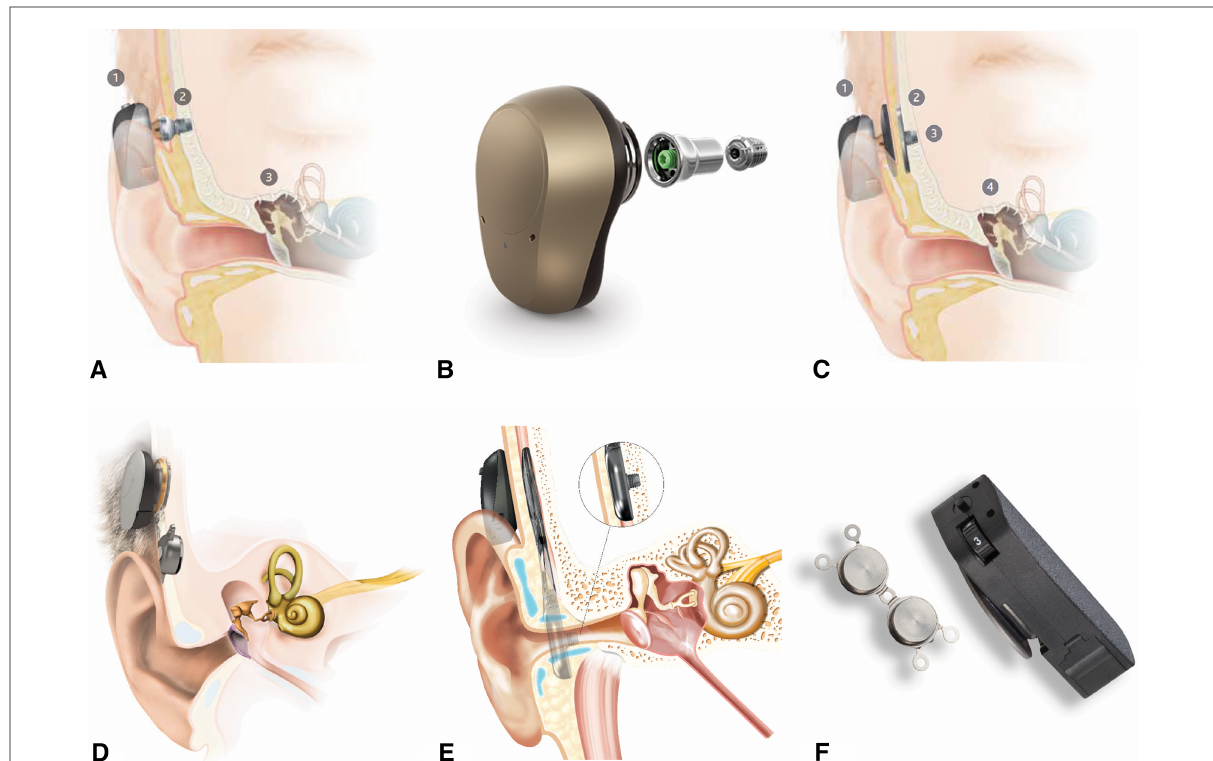
FIGURE 6 Surgical bone conduction devices. ( A ) Cochlear BAHA ® with osseointegrated percutaneous abutment. ( B ) Ponto ® with abutment and screw for osseointegration. ( C ) Cochlear BAHA ATTRACT ® with subcutaneous magnet. ( D ) Med-El BoneBridge ® with subcutaneous magnet. ( E ) Cochlear OSIA ® with subcutaneous magnet. ( F ) Medtronic magnetic